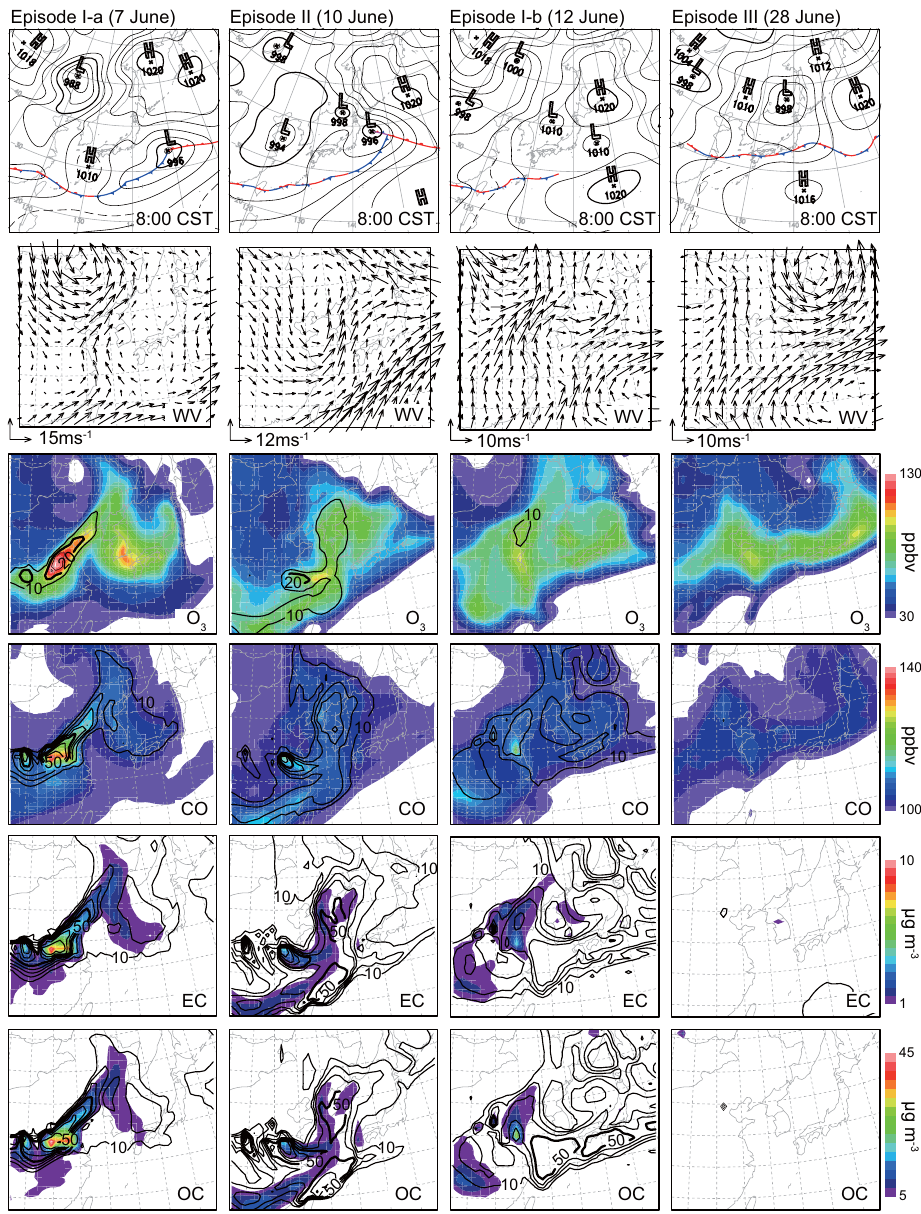
Fig. 8. Spatial distributions of surface meteorological fields and simulated atmospheric concentrations for Episode I-a on 7 June, Episode I-b on 12 June, Episode II on 10 June, and Episode III on 28 June 2006 over East Asia. Top four panels: The surface weather chart at 08:00CST/00:00UTC for each day is also shown on the top line from Japan Meteorological Agency (http://www.data.jma.go.jp/fcd/yoho/ hibiten/index.html). The second four panels are: Simulated wind fields below approximately 1000m altitude. Bottom panels: O 3 , CO, EC and OC concentrations (colors), approximately < 1000m altitude. Contours are impacts of open crop residual burning in China (%): thick solid lines are drawn each 20% for O 3 and 50% for CO, BC, and OC; thin solid lines are drawn each 10% for O 3 , CO, BC, and OC. The impacts are calculated from the differences between 06DS and the other simulation without emissions from open crop residual burning in